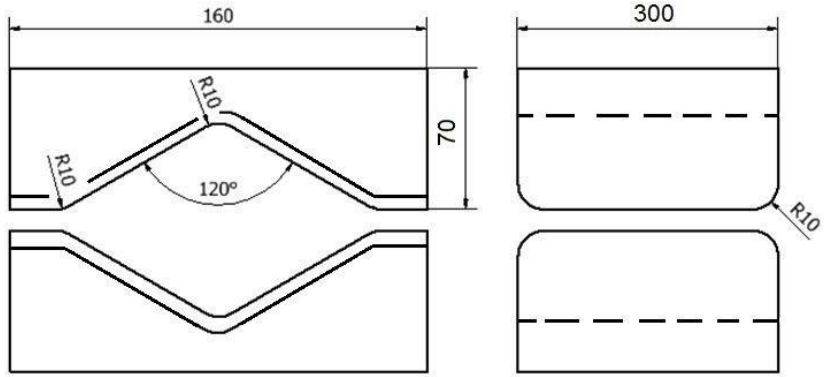
Figure 2. Shape and dimensions of flat anvils used to deform the zirconium alloy.